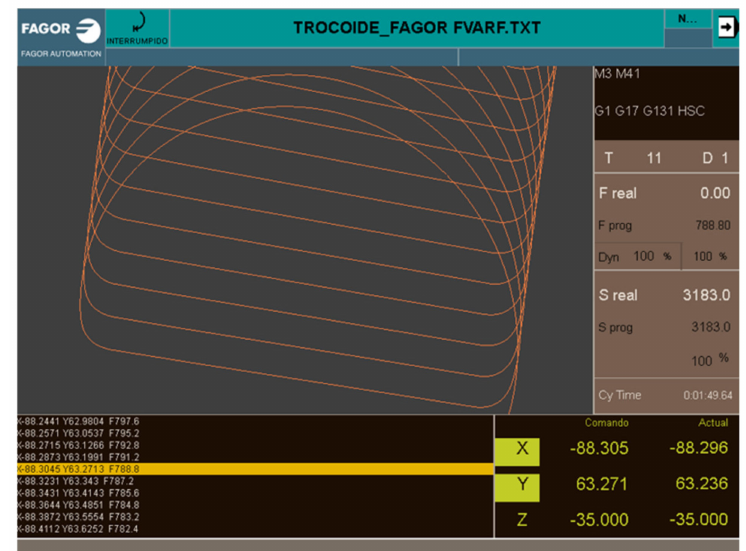
Figure 23. Trochoidal roughing adapted to a spiral groove.